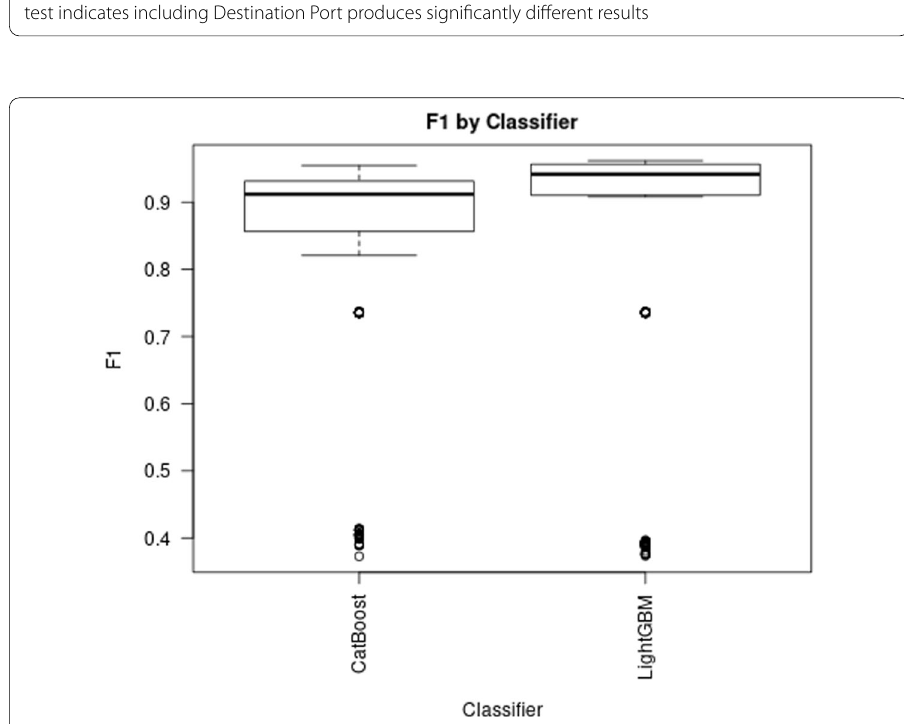
Fig. 11 Box plots of performance in terms of F1-score grouped by classifier; Tukey’s HSD test indicates classifiers are significantly